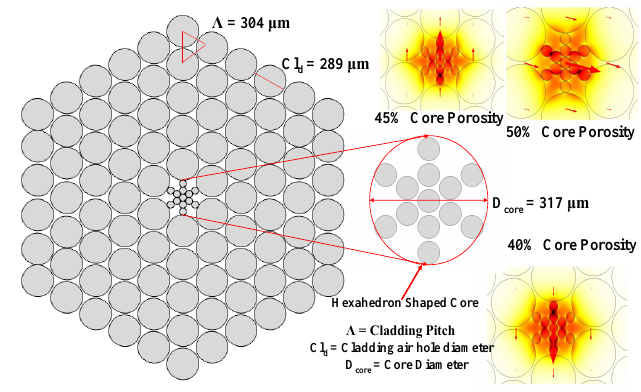
Figure 1. Schematic view of proposed PCF with modes field for different